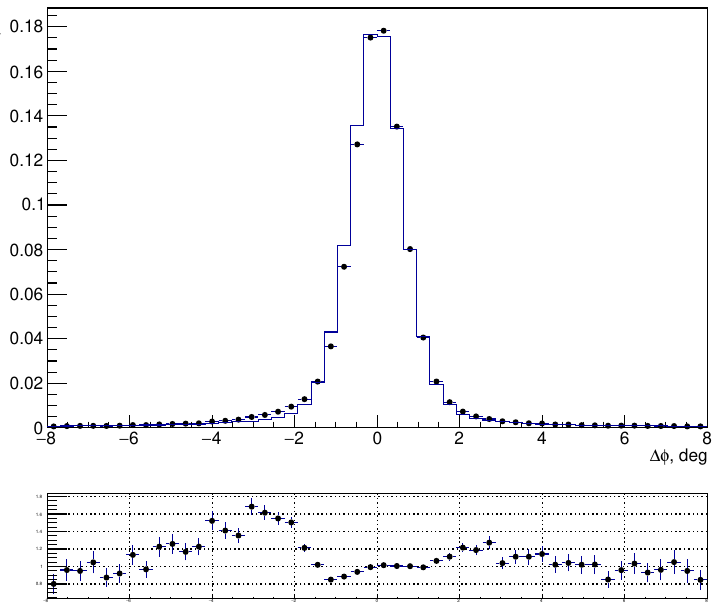
p s = 778 MeV. The solid histogram